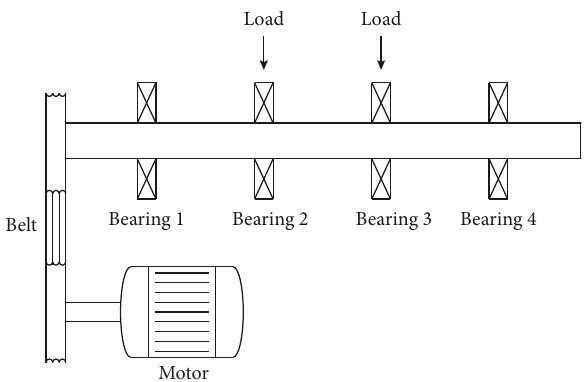
Figure 5: Experimental